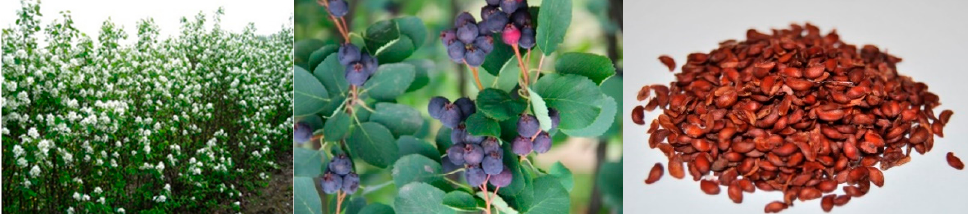
Figure 1. Flowering shrubs ( left ), ripe fruits in clusters ( center ), and ripe seeds ( right ) of cv. ‘Martin’ of the Saskatoon berry.